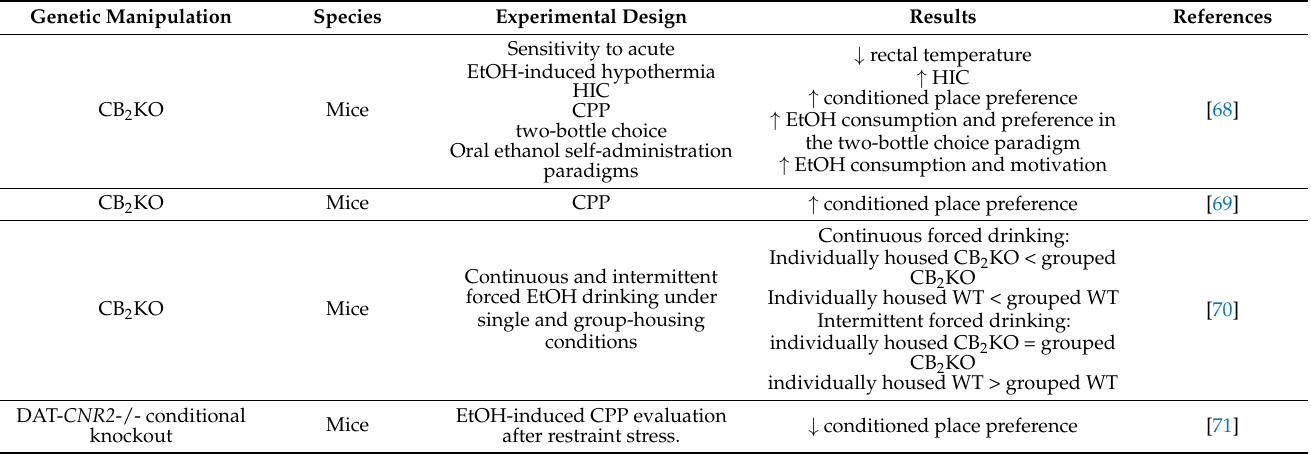
Table 2. Summary of the experimental studies evaluating the influence of the genetic manipulation of CB 2 r in animal models of alcohol